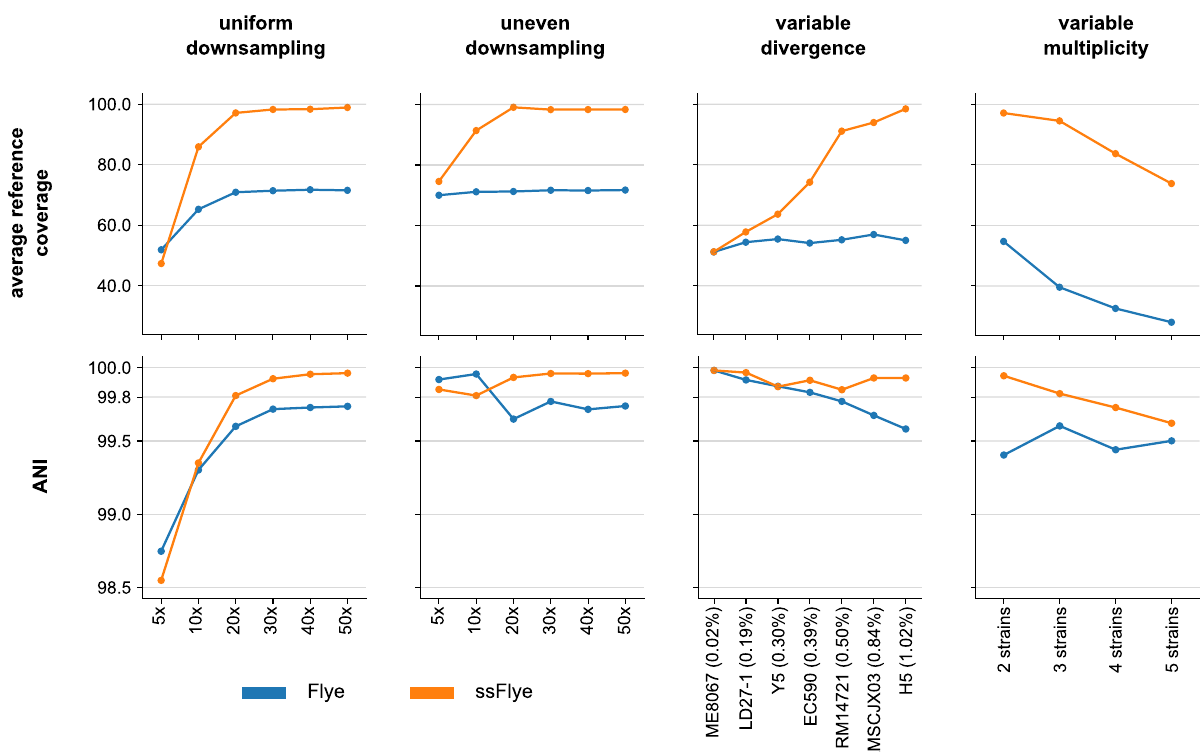
Fig. 4 Evaluation of strain-separated assemblies with respect to strain coverage, divergence, and number of strains. Average reference coverages and nucleotide identities of the strain-oblivious Flye assemblies and the Strainberry separated assemblies (ssFlye) on simple mock communities characterized by variable strain coverage ( fi rst two columns), divergence (third column), and number of strains (fourth column). The variable coverage communities are downsampled versions of the Mock3 dataset ( B. cereus , E. coli strain K-12, and E. coli strain W). We kept the same depth of coverage among the strains (uniform downsampling) or a constant 50× coverage for B. cereu s and E. coli strain K-12 while downsampling exclusively E. coli strain W (uneven downsampling). The variable divergence datasets consist of simulated reads from two strains where one is E. coli strain K-12 and the other one is listed on the x-axis (with the divergence percentage shown in parenthesis). The datasets with variable number of strains contain 2, 3, 4, and 5 conspeci fi c strains of E. coli with pairwise divergences ranging from 0.7% to